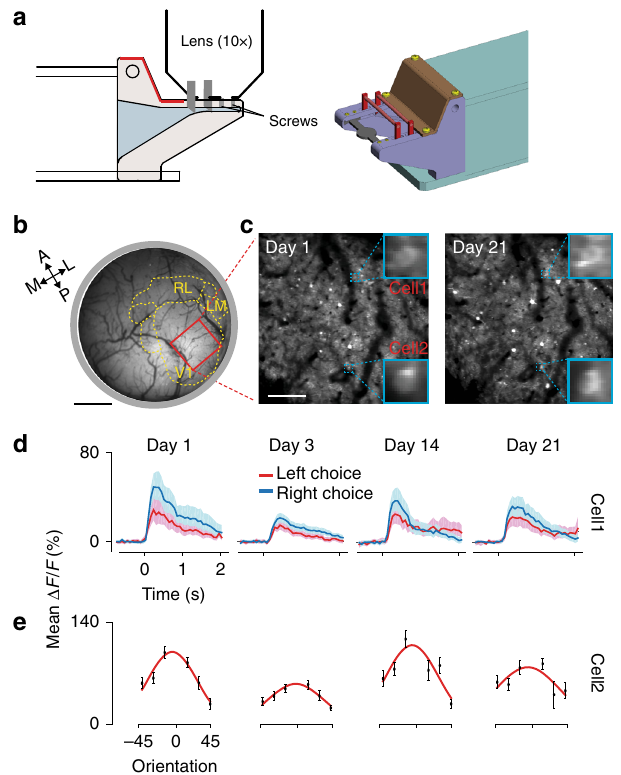
Fig. 5 Compatibility of the setup with two-photon imaging. a Left panel: side view schematic of the latching unit for physiology with a ×10 objective lens for two-photon imaging. The two vertical gray segments indicate the latching pins (Supplementary Fig. 6). Right panel: 3D rendering of the latching part of the unit. b Wide- fi eld GCaMP8 fl uorescence image at the cortical surface. Red rectangle, ROI within V1. Scale bar 1 mm, dotted yellow lines and labels are segmented visual areas (Methods). c Repeated imaging of the same ROI across different days. Blue squares are magni fi ed views of two example cells. Scale bar, 200 μ m. d Visually evoked responses during the behavioral task recorded from cell1 shown in c . Δ F/F trial averages for left/right choices (red/blue lines). Shaded areas, 95% con fi dence interval. Time-out trials were not included in the data. e Responses to oriented gratings (30° diameter) from cell-2 shown in c . Error bars are s.e.m. Red curves, Gaussian fi t to the data. Original technical drawings in a edited with permission from O ’ Hara & Co.,